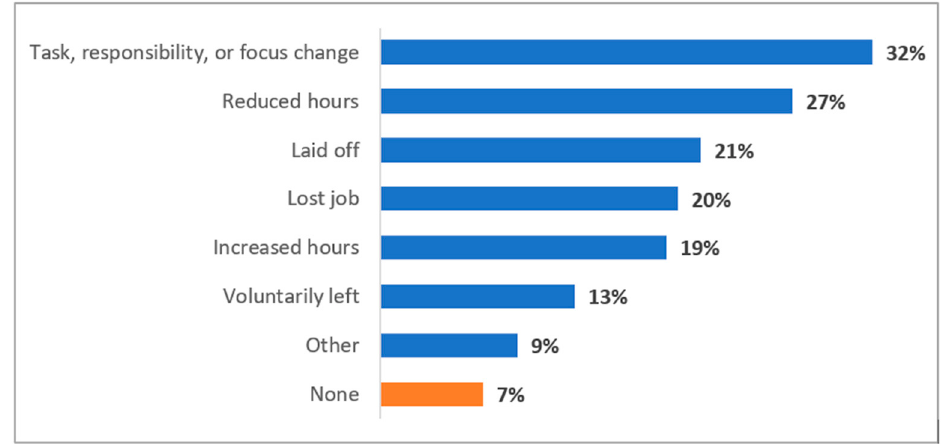
Figure 3. Pre-COVID impact on employment ( n = 133).